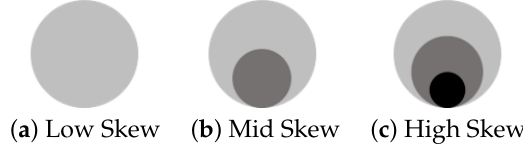
Figure 11. The redesigned texture to represent